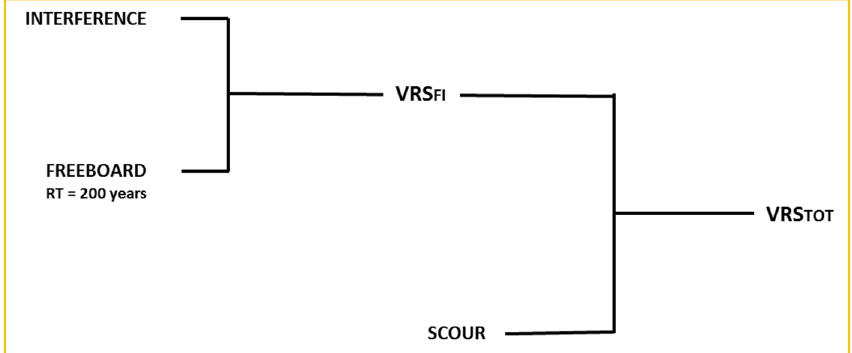
Figure 4. Flow chart describing the methodology employed to evaluate the vulnerability of roads in the floodplain (ramps to the bridge, roads embankment, etc.).